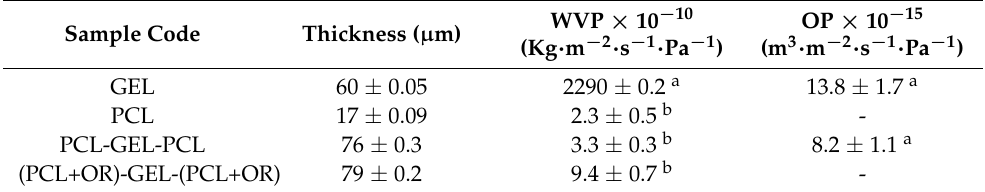
Table 2. Sample thickness, water vapor, and oxygen permeance of GEL, PCL, PCL-GEL-PCL, and (PCL+OR)-GEL-(PCL+OR)